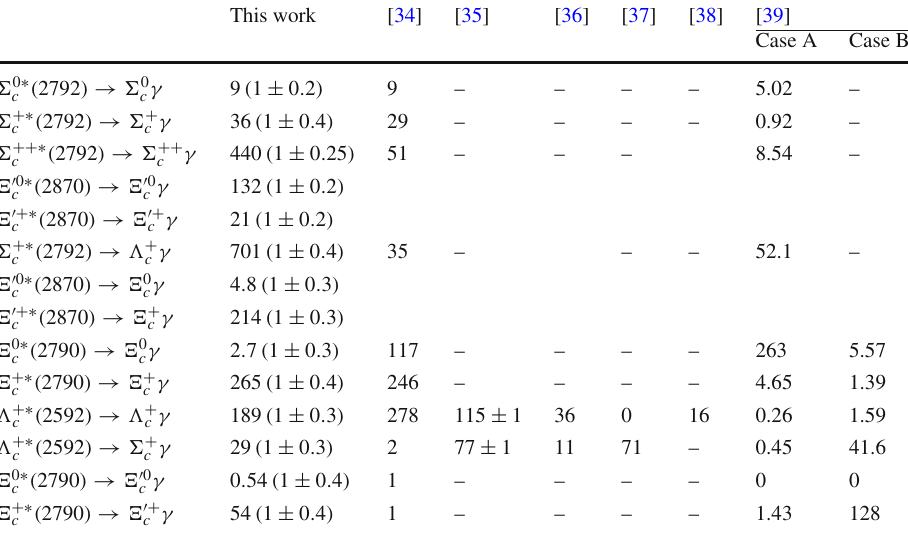
Table 2 The values of radiative decay widths (in units of